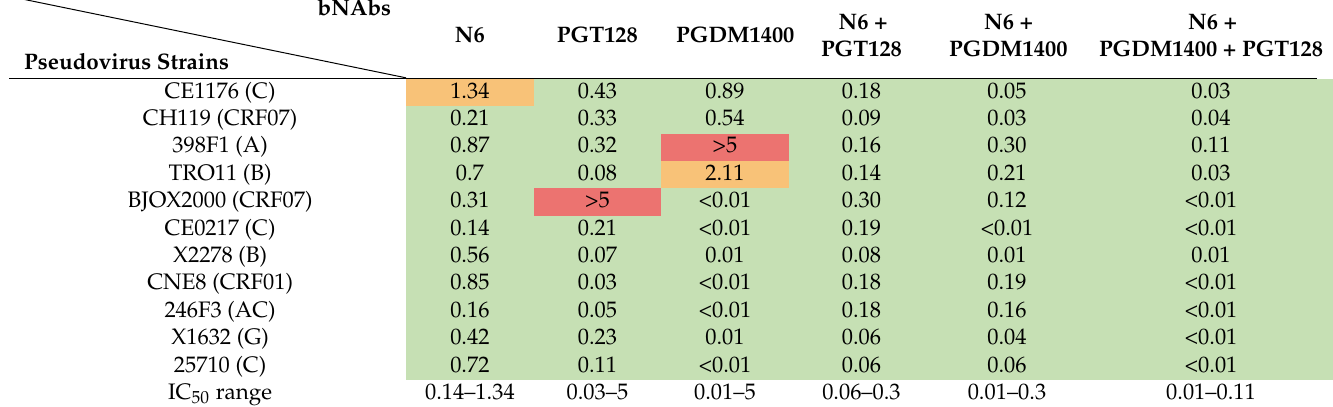
Table 4. IC 50 values for antibodies N6, PGT128, PGDM1400, and their